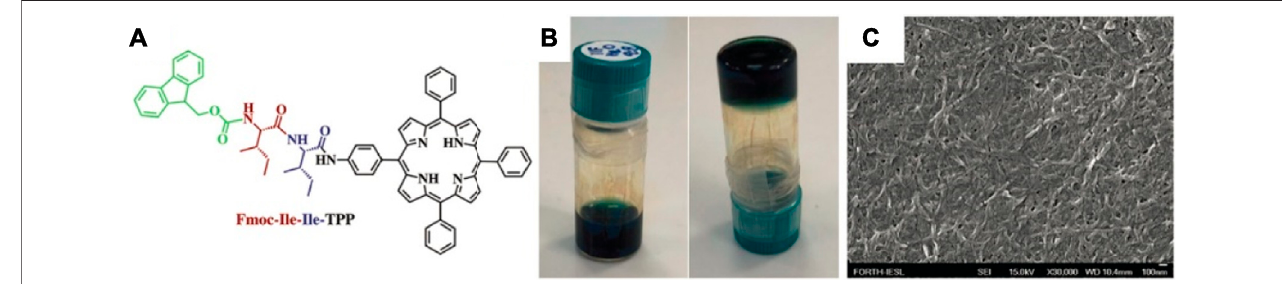
Frontiers in Chemistry |